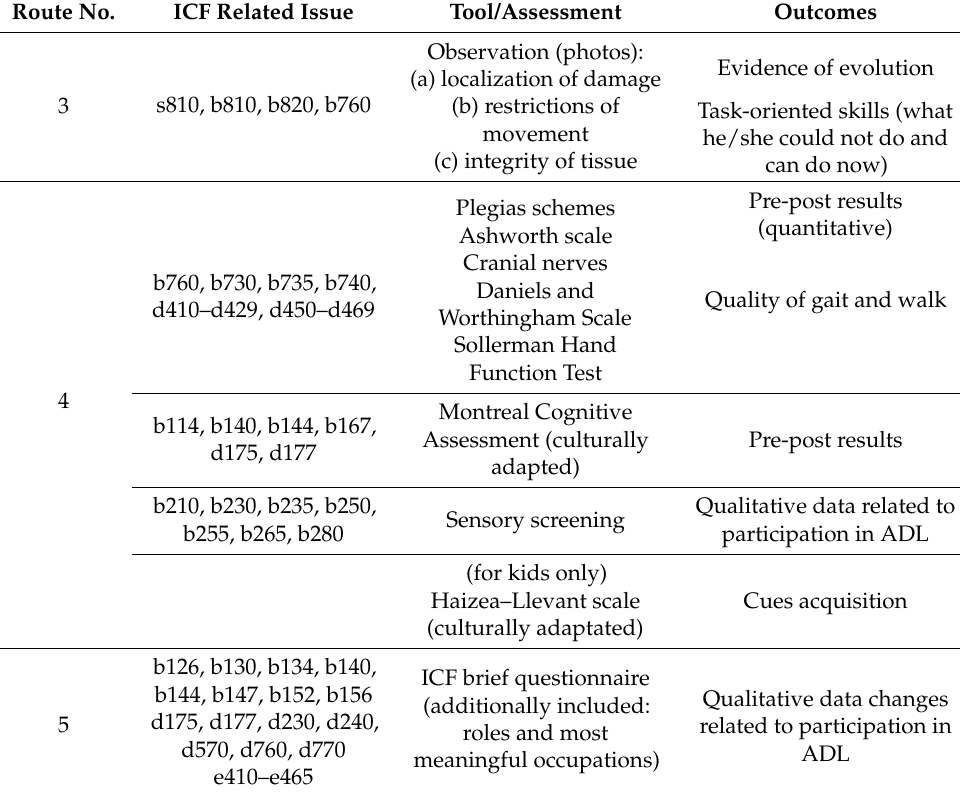
Table 2. Summarised assessments and outcomes measures in protocol routes. Route